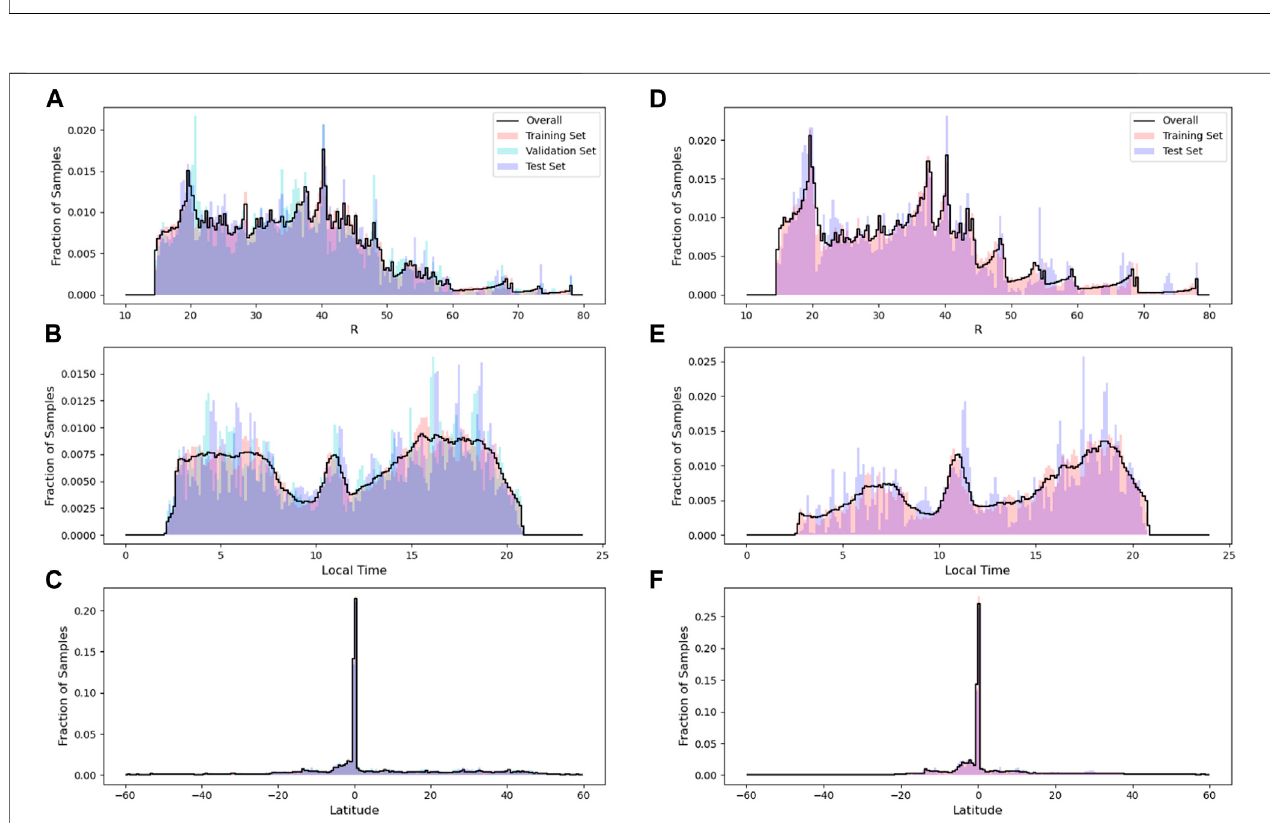
FIGURE 4 | Histogram of spacecraft position in KSM coordinates for Saturn radius [R; (A) and (D) ], local time [ (B,E) ] and latitude [ (C,F) ] for the 1-min interpolated MAG-only data used in the RNN approaches (left panels) and 10-min interpolated MAG and full particle data set used in the RF/SVM/LR approach. For the RNN approach the data is split across the overall data set (black line), training set (red), validation set (cyan) and test set (blue). For the RF approach, a validation set was not used but the time periods of the test and training sets were matched as closely as possible to the RNN data sets for the sake of comparison. The histograms are scaled relative to the total number of samples in each set (for the 1-min interpolated data: N train = 504,338, N val = 109,582, and N test = 109,259; for the 10-min interpolated data N train = 103,665 and N test =